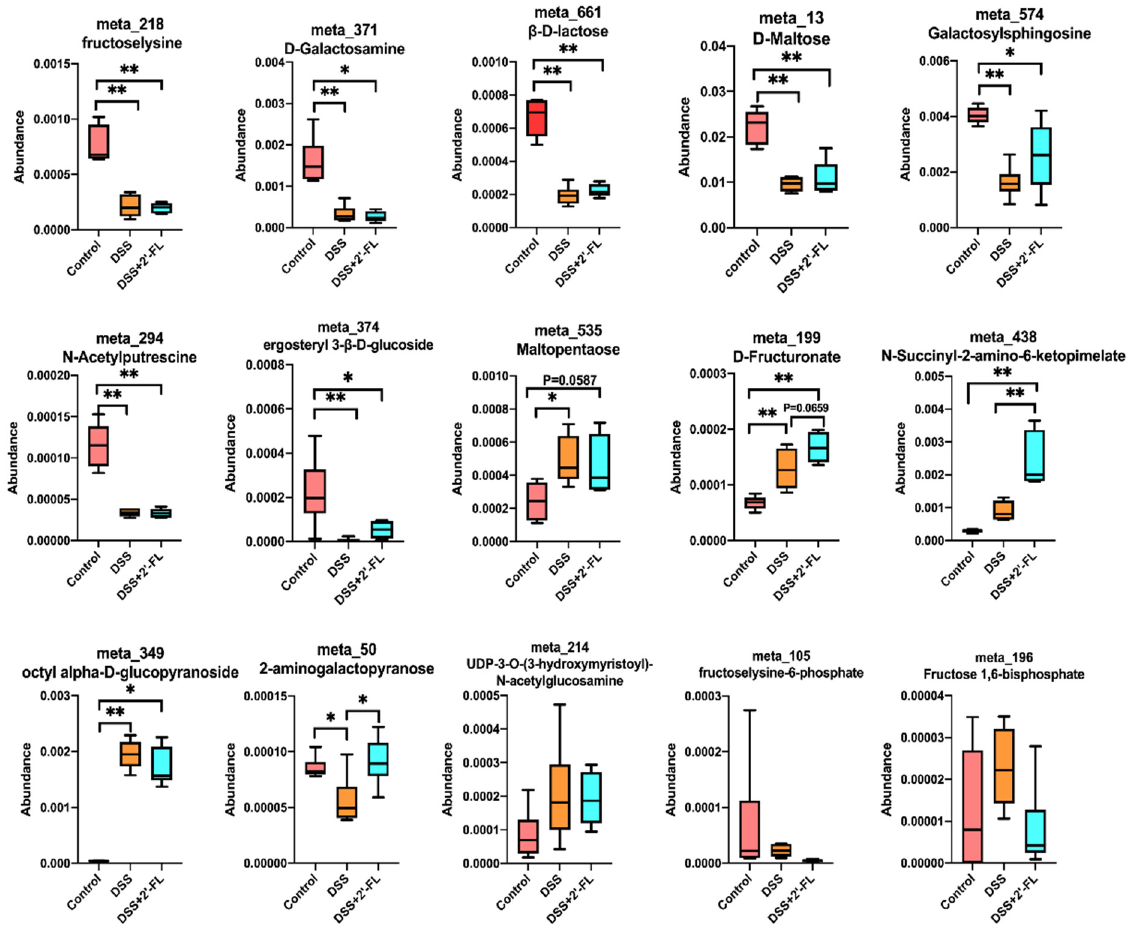
Figure 4. The profile of glycometabolism was significantly altered among the three groups.